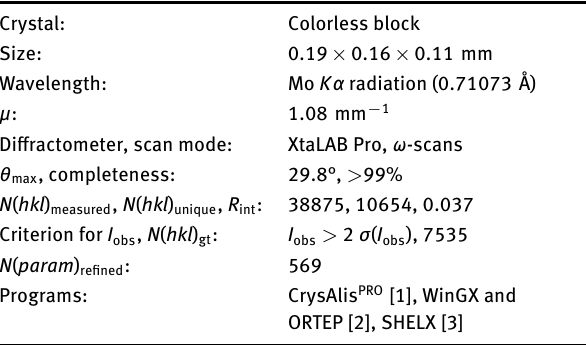
Table 1: Data collection and